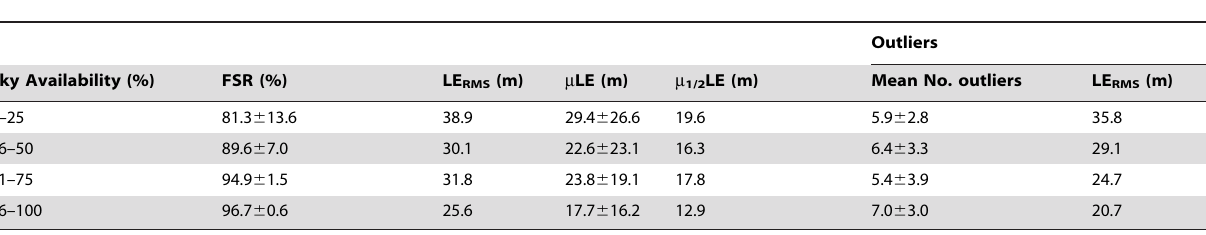
Table 2. Fix success rate (FSR 6 SD), root mean square of location errors (LE RMS ), and the mean ( m LE 6 SD) and median ( m 1/2 LE 6 SD) location errors for positional fixes collected from lightweight GPS collars during stationary collar tests under four sky availability classes across three suburban habitat types (n=36), Dunedin, New Zealand.